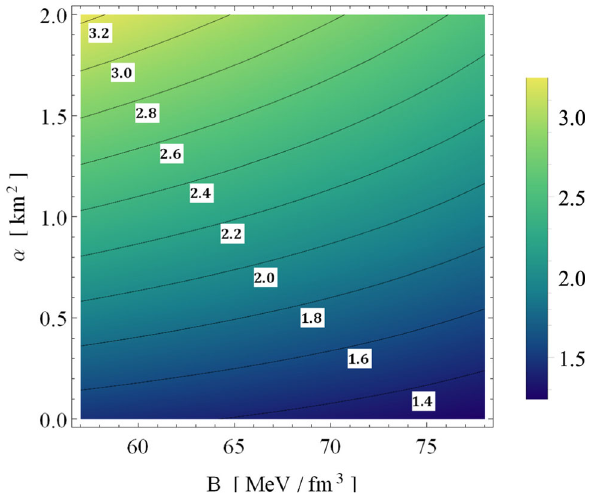
Fig. 12 B − α plane for equi- M / M (cid:3) for R = 9 . 69km , b = 0 . 000015 / km